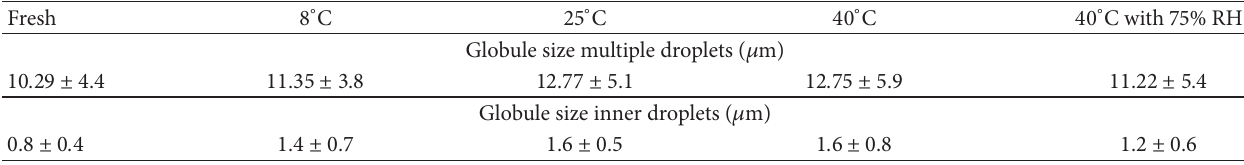
Table 2: Mean globule size of 5% green tea multiple emulsions followed for 30 days.